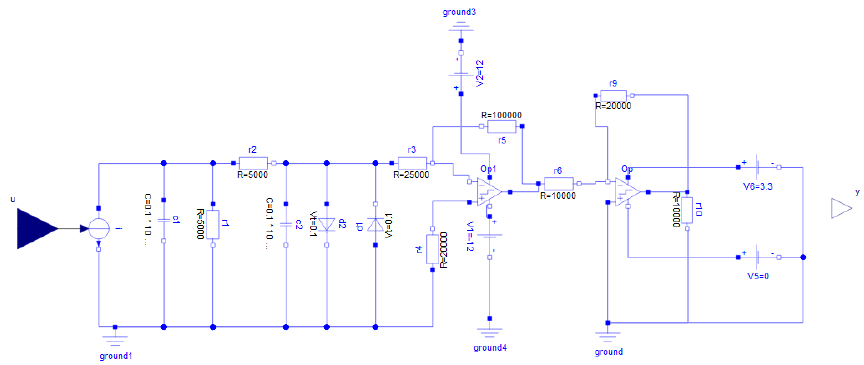
Figure 7. Rotor speed sensor conditioning circuit model in Modelica.